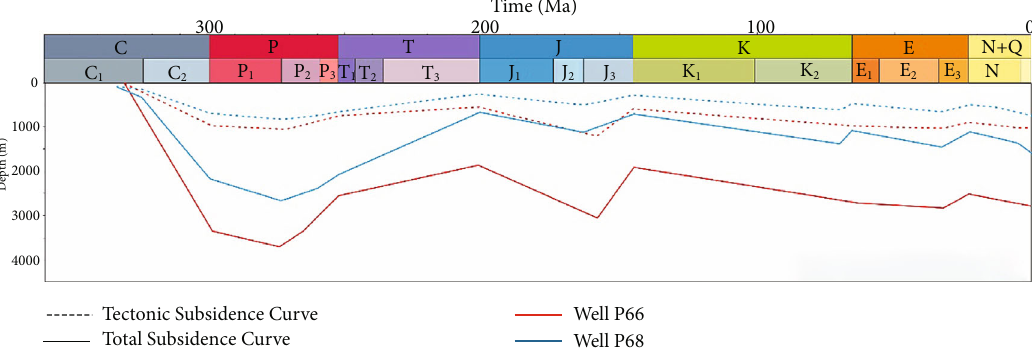
Figure 4: Tectonic subsidence curve and total subsidence curve of well-P66 and